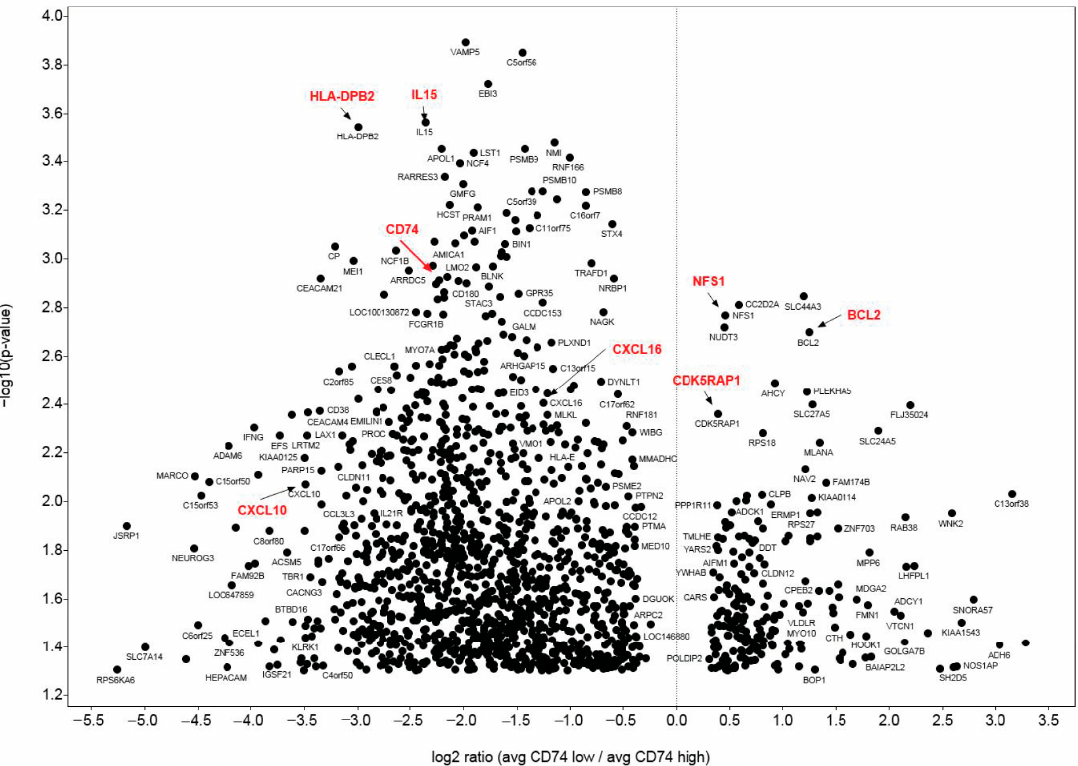
Figure 5. A Volcano Plot of the Genes in Association with CD74 in Stage IV Melanoma. The genes on the left side are lower in the “CD74 low” group compared to the “CD74 high” samples, while the genes on the right side have higher expression in the “CD74 low” samples.